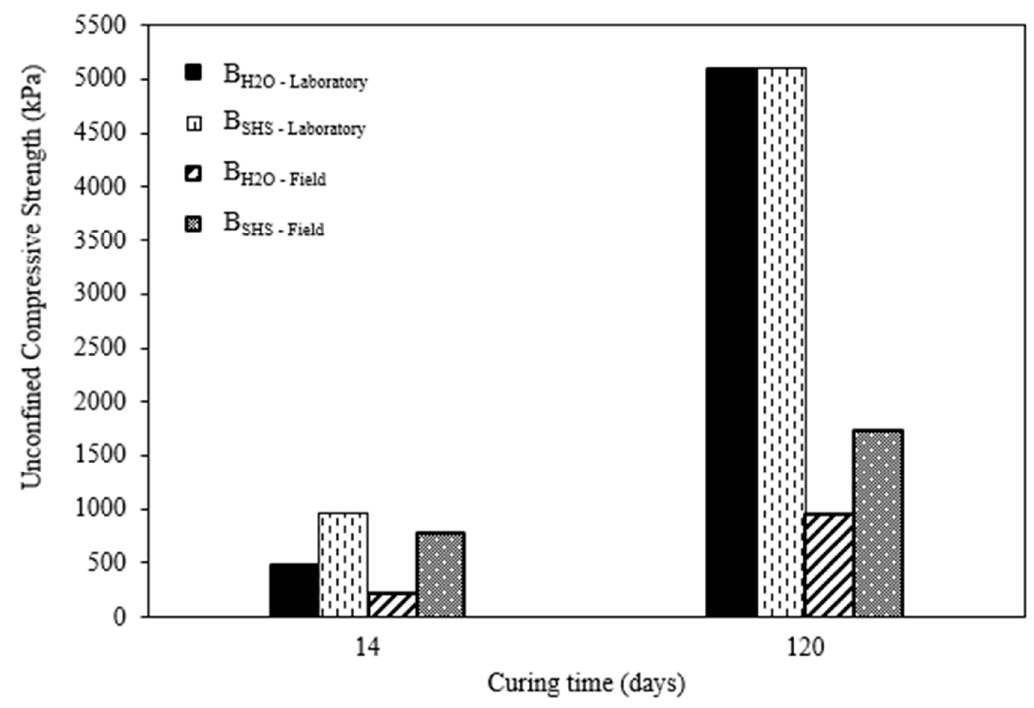
Figure 9. UCS for field and laboratory samples for curing time of 14 and 120 days.